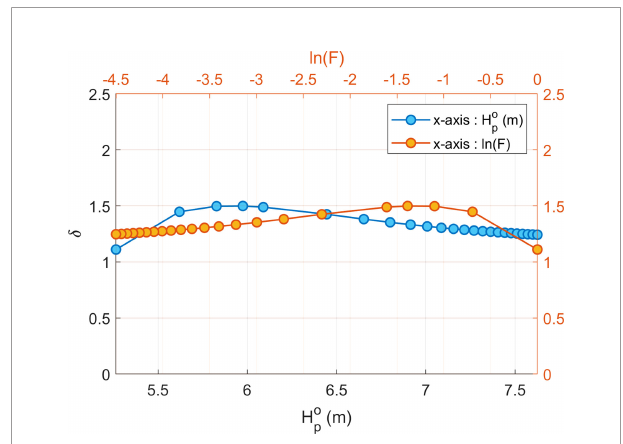
FIGURE 2 | d value according to the peak height of a storm wave event in the deep sea H o p , F nd return frequency F